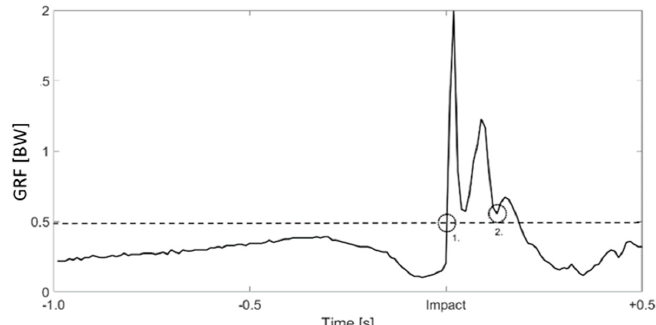
Figure 2. An example of the normal ground reaction force (GRF) (black line) from 1.0 s before the impact until 0.5 s after it. The dashed line represents 0.5 body weight (BW), used as threshold for the start of the landing (1.), while the end of the landing (2.) was defined as the minimum GRF after the second peak.